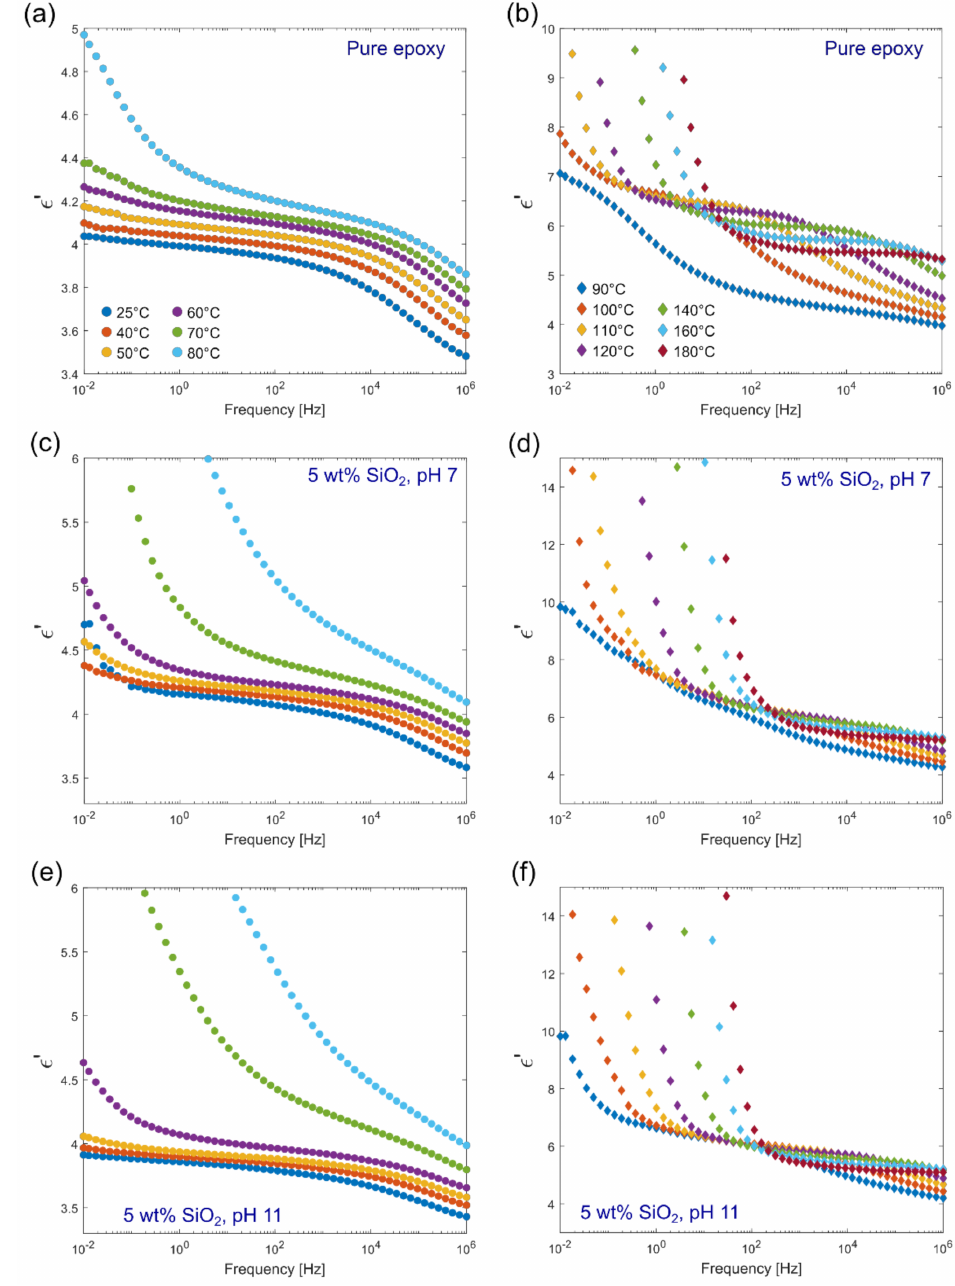
Figure 9. The real relative permittivities ( ε ’) for ( a , b ) pure epoxy, and epoxy nanocomposites prepared with 5 wt.% SiO 2 at ( c , d ) pH 7, and ( e , f ) pH 11. The plots on the left ( a , c , e ) show the permittivities below 80 ◦ C, while the plots on the right ( b , d , f ) show the permittivities above 80 ◦